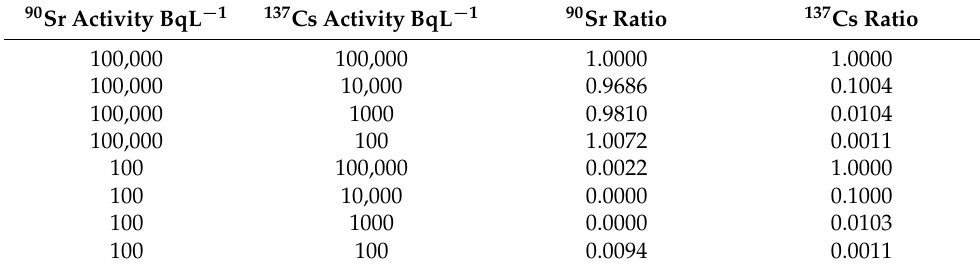
Figure 3. The spectrum corresponding to the radionuclide mix in Table 4 output by the detector is plotted in black, and the reconstructed spectrum resulting form the linear regression is plotted in red. Table 3. The ratios of 90 Sr and 137 Cs mixed to different activities as determined by linear regression